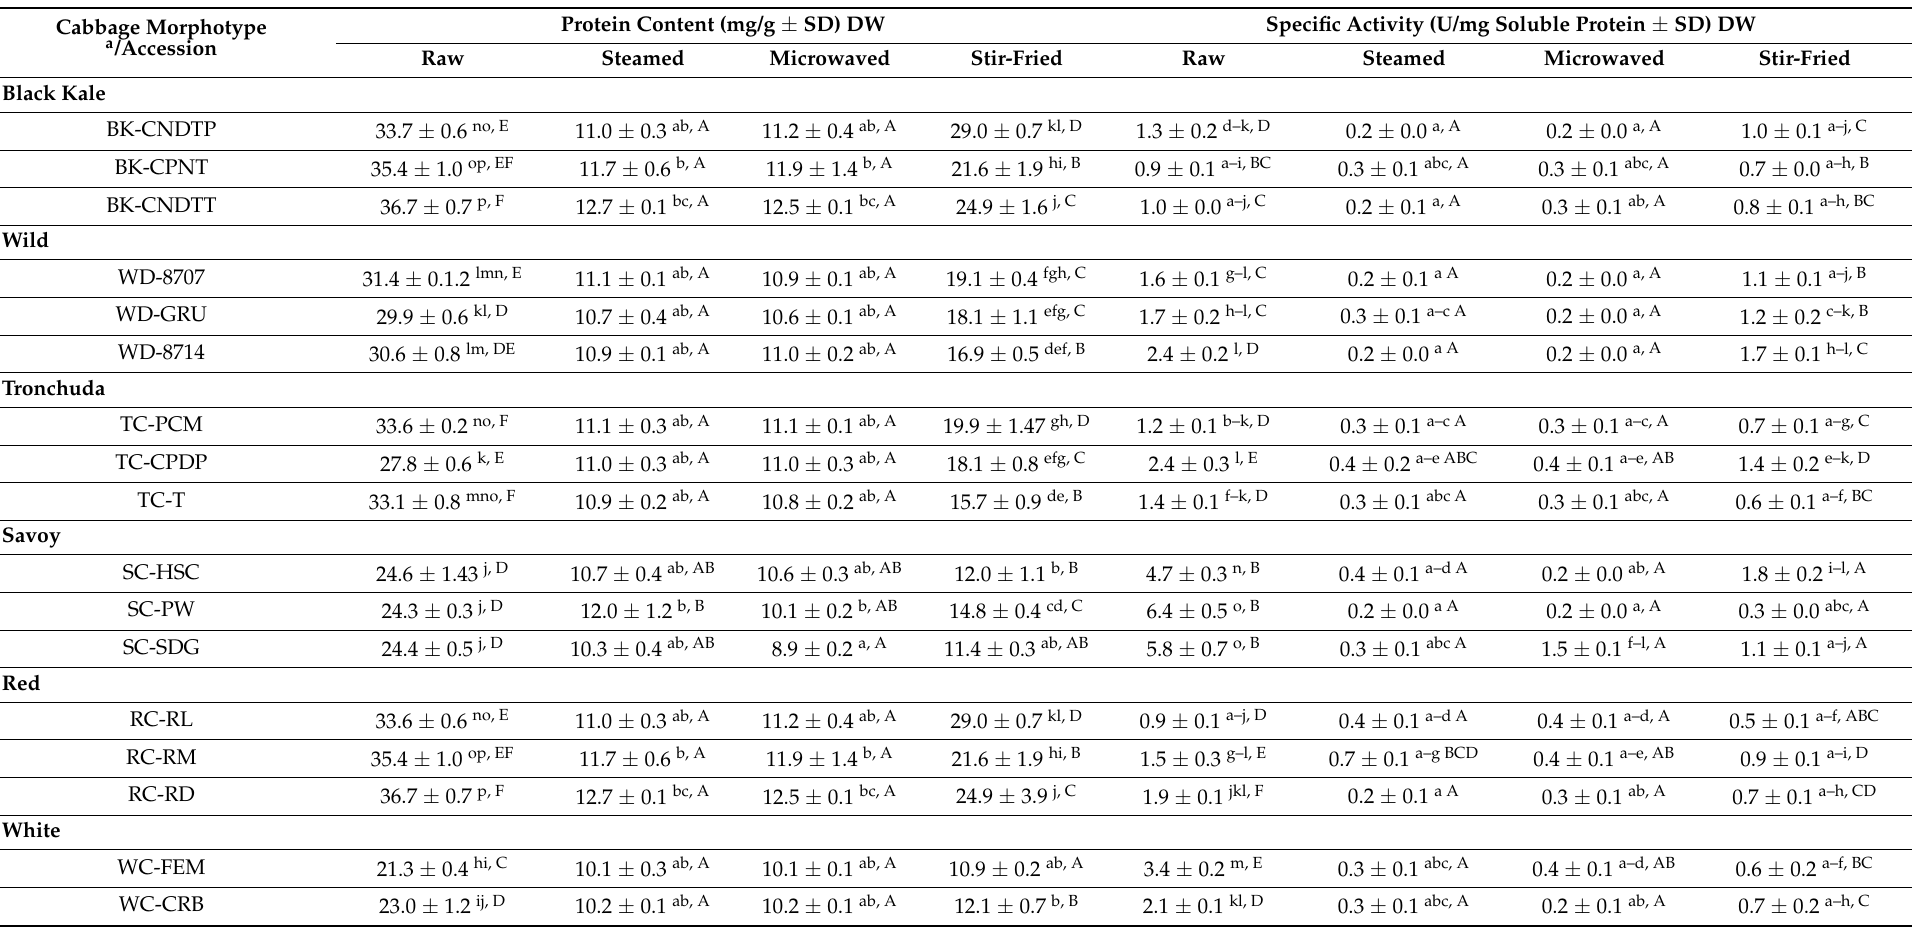
Table 3. Protein content ((mg/g ± SD) DW) and specific activity ((U/mg soluble protein ± SD) DW) of cabbage accessions before and after domestic processing. Cabbage Morphotype a